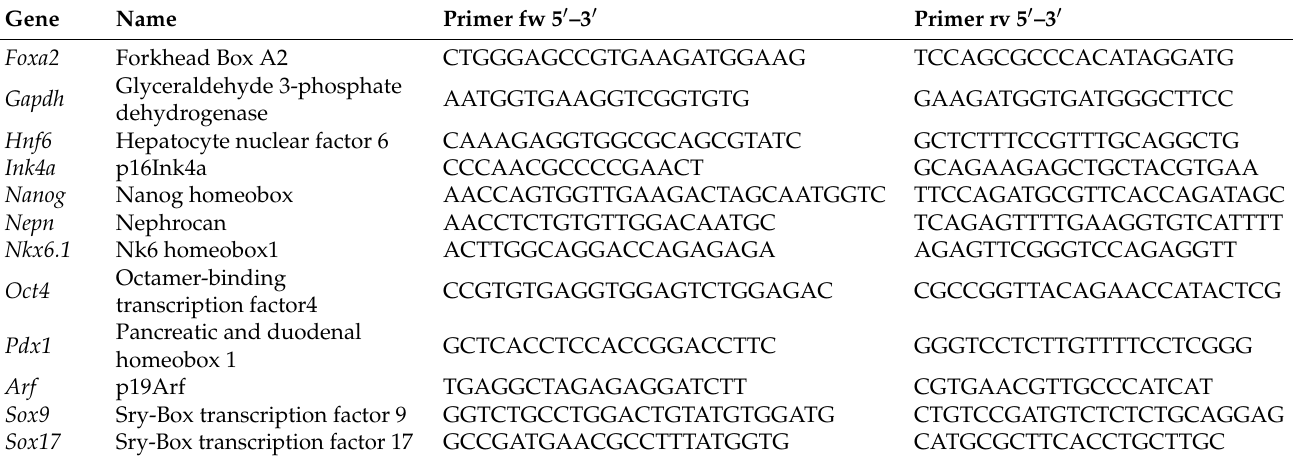
Table 1. List of genes and sequences of primers used for relative gene expression analysis by